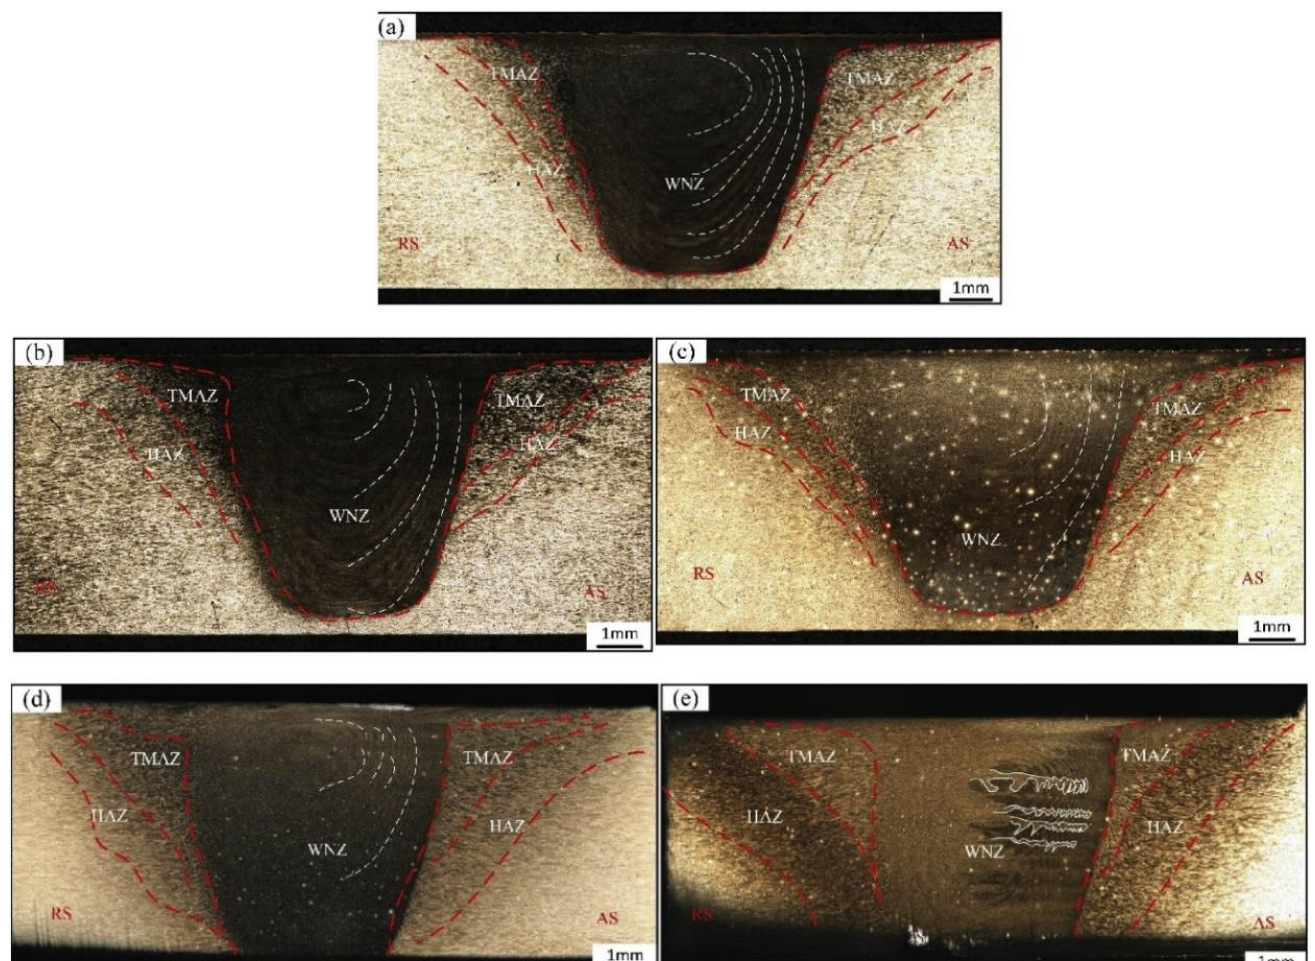
Figure 3. Macroscopic morphology of EA-FSWed joints of AA2219 using a current of ( a ) 0 A, ( b ) 200 A, ( c ) 400 A, ( d ) 500 A, ( e ) 600 A. The white dotted lines present the material flow direction. Reprinted with permission from ref. [30]. Copyright 2022 Elsevier.